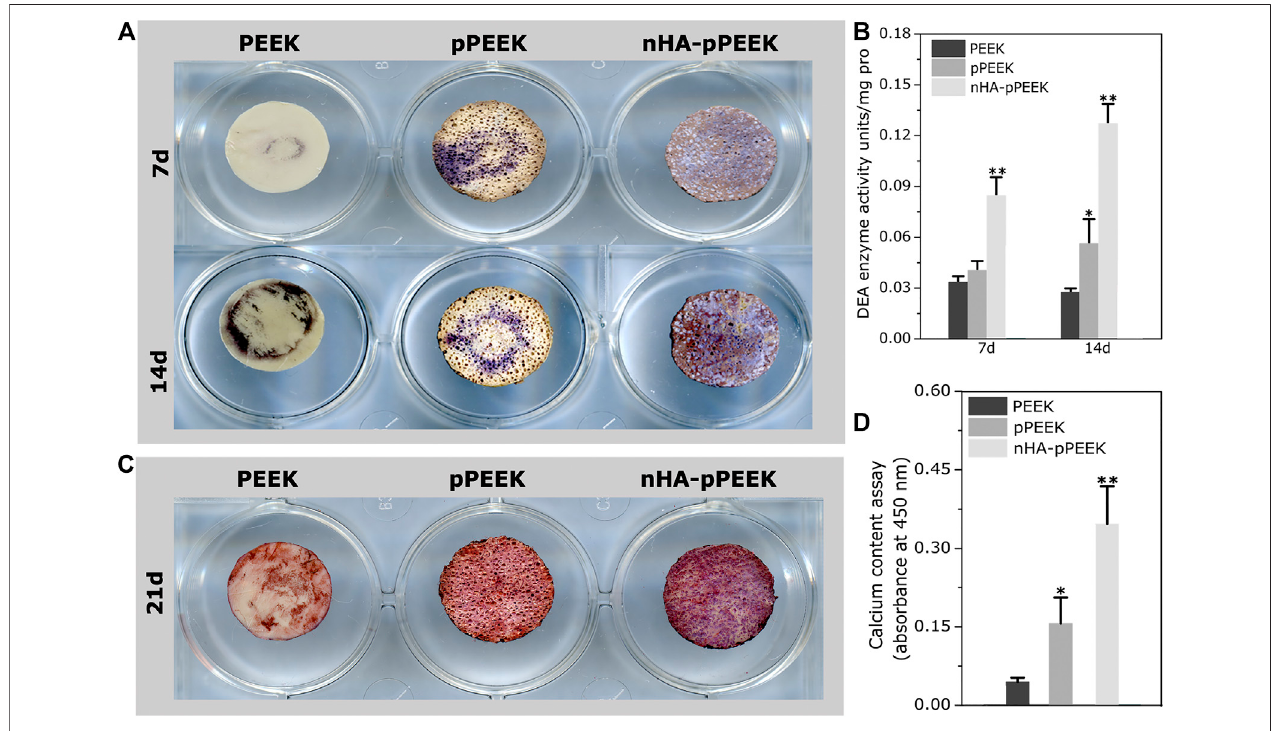
FIGURE 3 | Osteogenic differentiation of MC3T3-E1 cells. (A) ALP staining assays of cells on the different materials after 7 and 14 days co-culture time. (B) ALP activity in cell lysates collected from cells co-cultured with different materials. (C) ARS staining of cells on the different materials. (D) Quanti fi cation of ARS staining in (C)